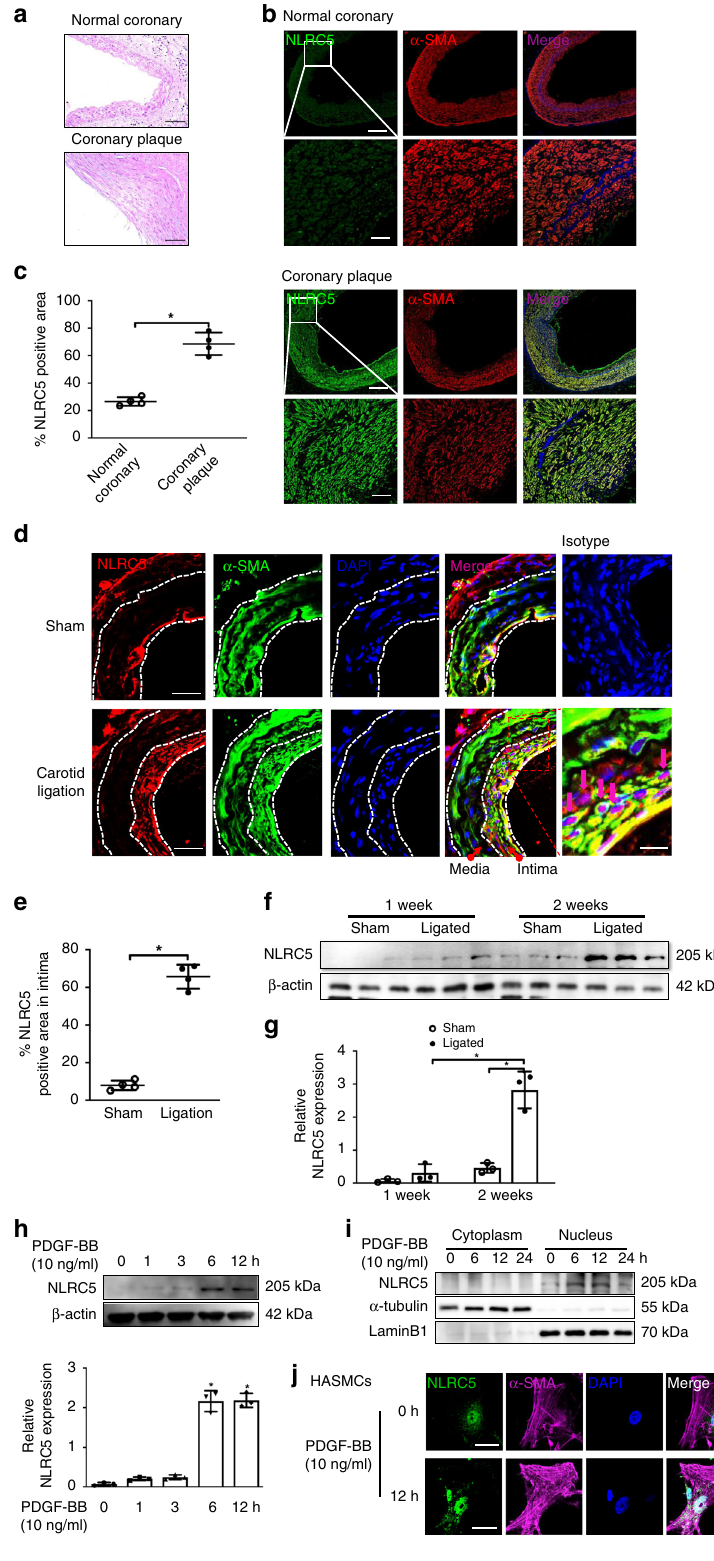
Supplementary Fig. 6A), and in peripheral blood ( Nlrc5 + / + 8.8 ± 0.3% vs. Nlrc5 − / − 7.2 ± 0.3%, P = 0.011 by Student ’ s t -test, Supplementary Fig. 6B) of Nlrc5 − / − mice. No differences in CD45 + CD11b + Gr1 + myeloid cells were found in bone marrow, spleen, and peripheral blood between Nlrc5 − / − and Nlrc5 + / +